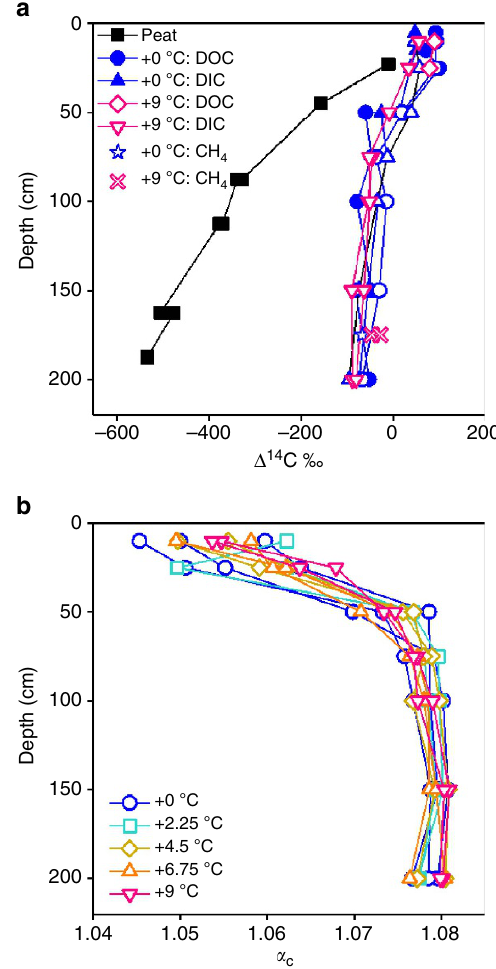
Figure 6 | Isotopic composition of respiration products and substrates. Depth profiles of ( a ) 14 C for solid peat, DOC, CH 4 and dissolved CO 2 (DIC), and ( b ) differences in stable carbon isotopic ( d 13 C) composition between DIC and CH 4 ( a C ¼ [( d 13 CO 2 þ 1000)/( d 13 CH 4 þ 1000)]) with depth during DPH (June 2015). In a , closed symbols represent values from control plots prior to DPH when no treatment (that is, þ 0 (cid:2) C) was applied, open symbols represent values from þ 9 (cid:2) C treatment plots during DPH (June 2015). In a , black squares denote radiocarbon peat values, closed blue circles denote radiocarbon DOC values from control (0 (cid:2) C) plots, blue triangles denote radiocarbon DIC values from control plots, magenta diamonds denote radiocarbon DOC values from þ 9 (cid:2) C plots, magenta inverted triangles denote radiocarbon DIC values from þ 9 (cid:2) C plots, blue stars denote radiocarbon CH 4 values from control plots, and magenta x ’s denote radiocarbon CH 4 values from þ 9 (cid:2) C plots. In b , blue circles denote a C from control plots, turquoise squares denote a C from þ 2.25 (cid:2) C plots, gold diamonds denote a C from þ 4.5 (cid:2) C treatment plots, orange triangles denote a C from þ 6.75 (cid:2) C plots and magenta inverted triangles denote a C from þ 9 (cid:2) C plots. Note the age difference between solid peat and all DOC and DIC